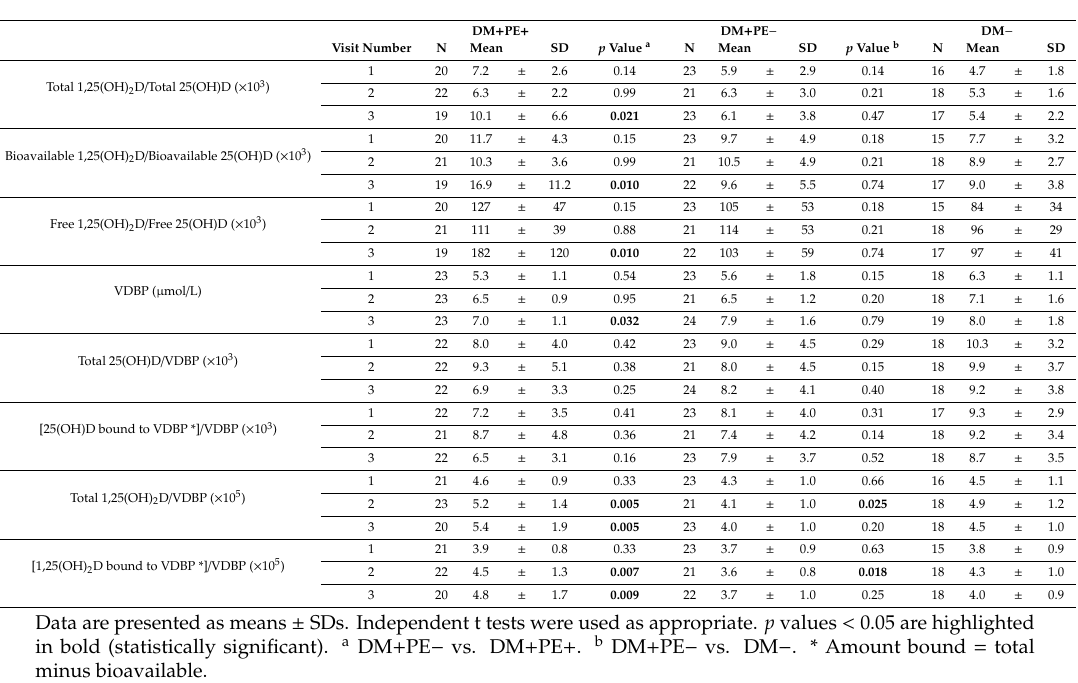
Figure 2. Maternal concentrations of total, bioavailable, and free 1,25-dihydroxyvitamin D (1,25(OH) 2 D), according to T1DM and/or PE status. Longitudinal changes in ( A ) total, ( B )